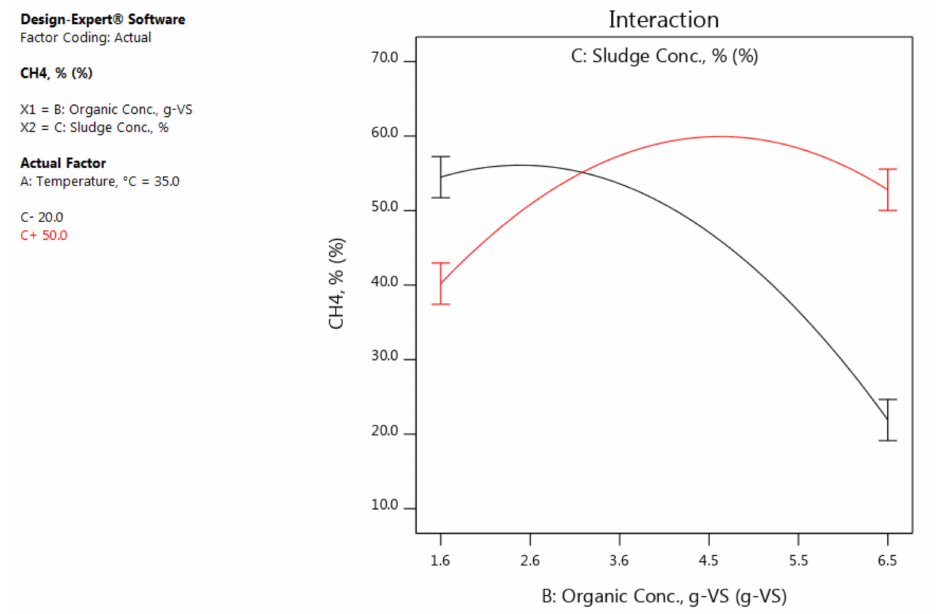
Figure 5. An interaction plot illustrating the influence of (BC) on the CH 4